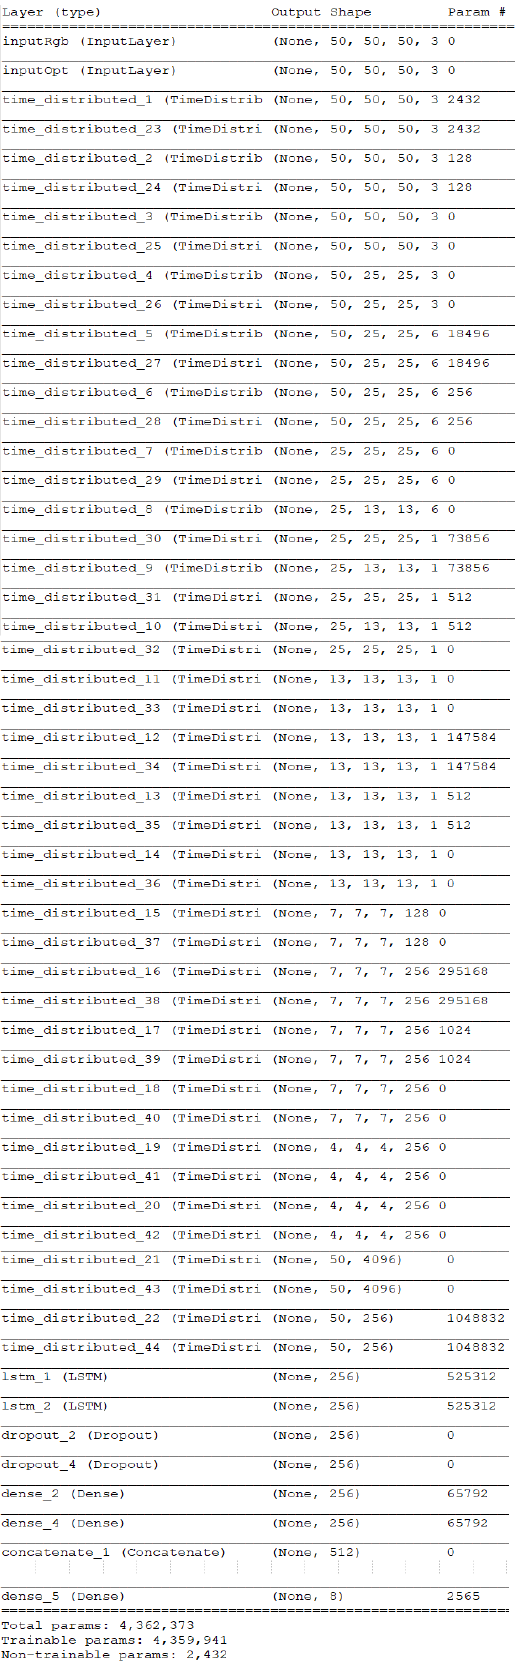
Figure A3. Dual-CNNSELSTM Output shape and number of weights in each layer.